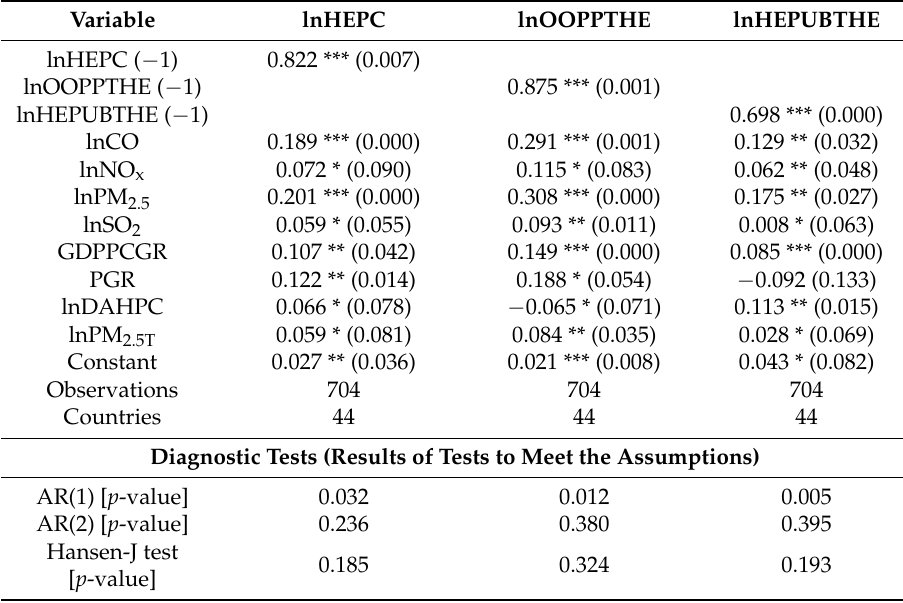
Table 1. Dynamic panel data estimation, two-step system